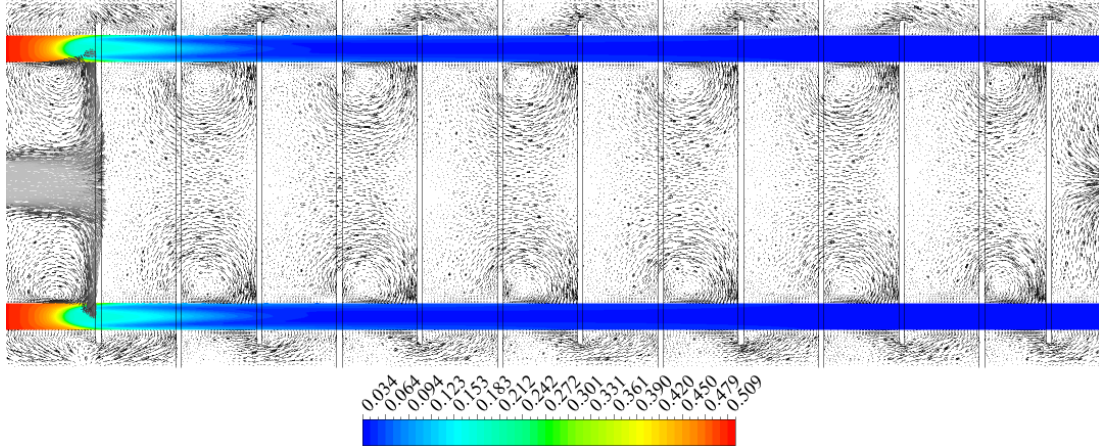
Figure 13. Reactor, longitudinal CO 2 mass fraction profile at x = 0, plane yz. Table 6. Outlet gas composition and SNG quality requirements (1 m reactor module).